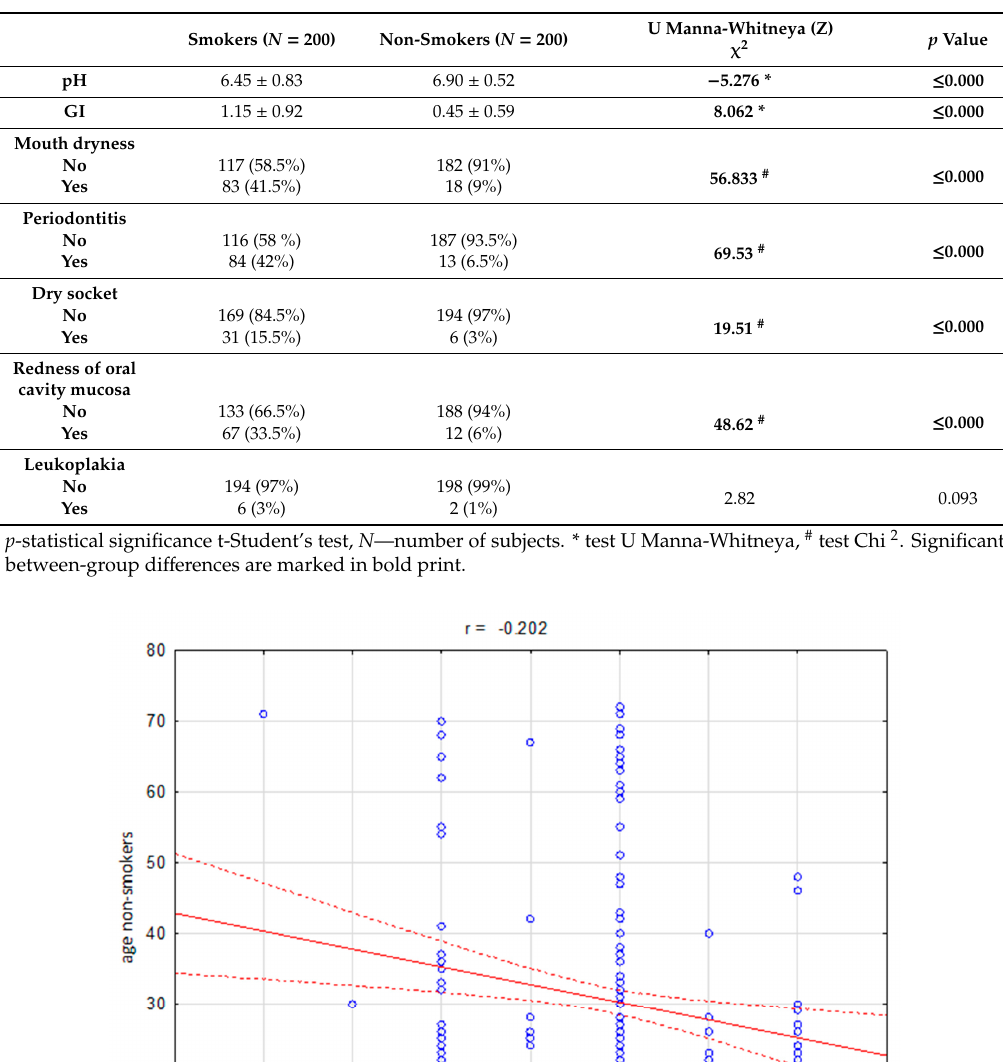
Table 4. Oral health status parameters in smokers and non-smokers groups.